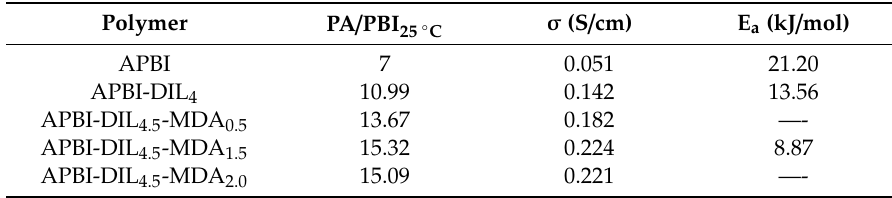
Table 2. Proton conduction activation energy calculated by APBI-dicationic ionic liquid (pr(mim) 2 Br 2 ) (DIL) / mesoporous silica (MDA) composite membranes. PA, phosphoric acid.